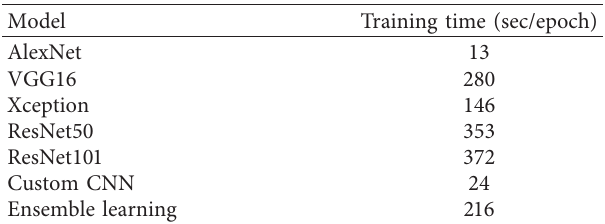
Figure 12: Performance analysis of proposed with different models. Table 5: Run time for different pretrained and custom CNN